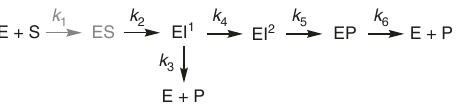
Fig. 3 General reaction mechanism for carbapenem hydrolysis by M β